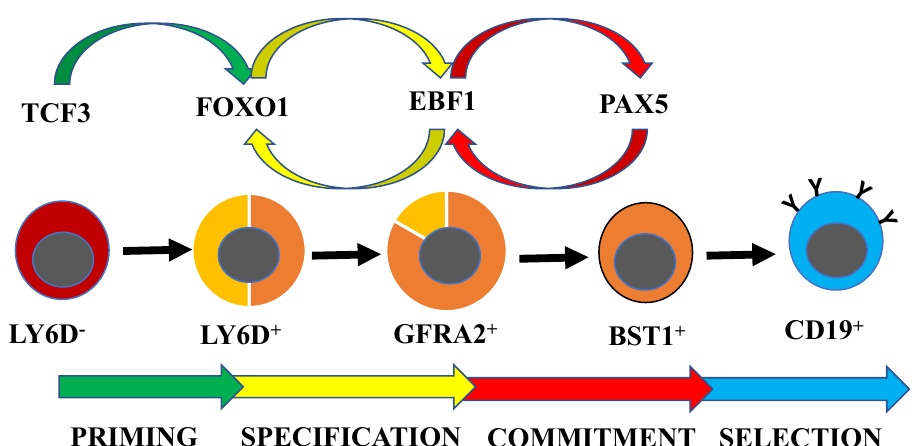
Figure 2. Schematic drawing of the transcription factor networks involved in priming (green arrows), specification (yellow arrows), commitment (red arrows), and selection (blue arrows) in early B-cell development. Red indicates B/T and NK cell potential, orange indicates B-cell potential, and yellow indicates residual T-cell potential. Blue indicates IgM + cells.